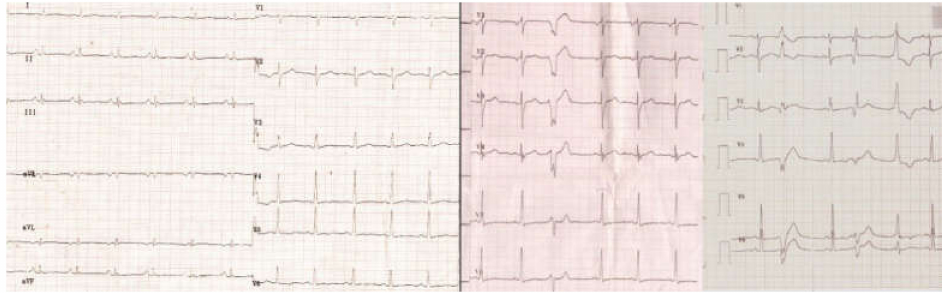
Figure 2. The ECG shows hypovoltage, nonspecific intraventricular conduction disturbances, nega- tive T-waves in V5-V6 and polymorphic ventricular